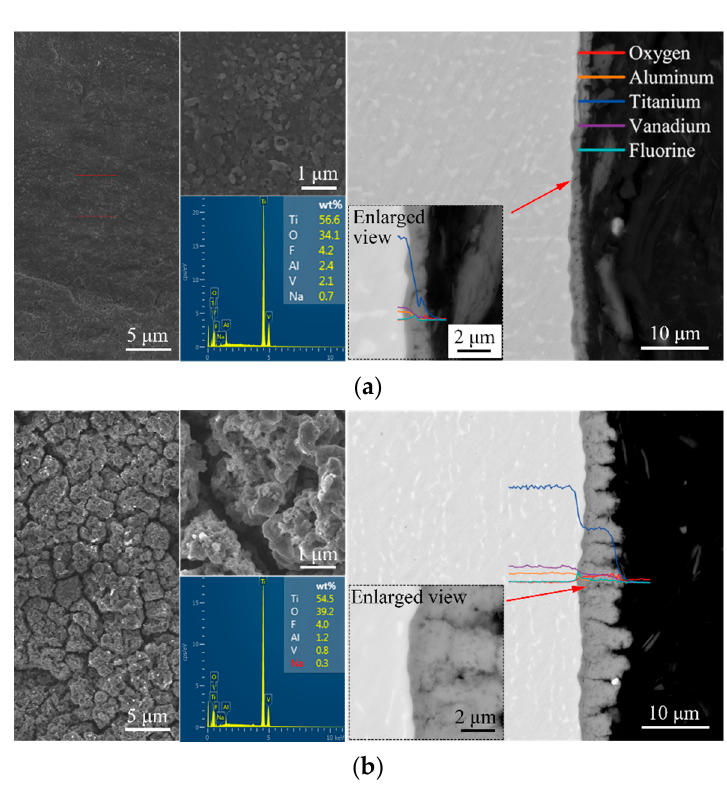
Figure 4. Surface morphology, cross-sectional morphology, and the corresponding EDS element distribution of the coating obtained by performing the MAO treatment in the NaF electrolyte for ( a ) 600 and ( b ) 12,000 s.